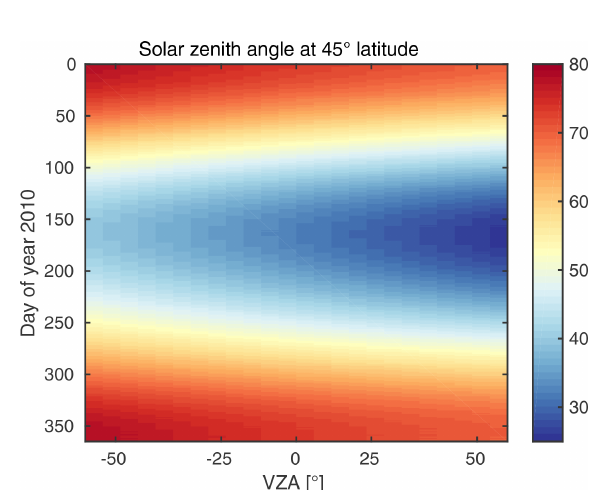
Figure 5. SZA depending on time and VZA at 45 ◦ N latitude. Data bins correspond to 24 discrete forward scan pixels and individual days in the x and y directions, respectively. GOME-2A performs a Sun-synchronous orbit at a fixed inclination to the Sun. Hence, the SZA unambiguously depends on time, VZA, and latitude.